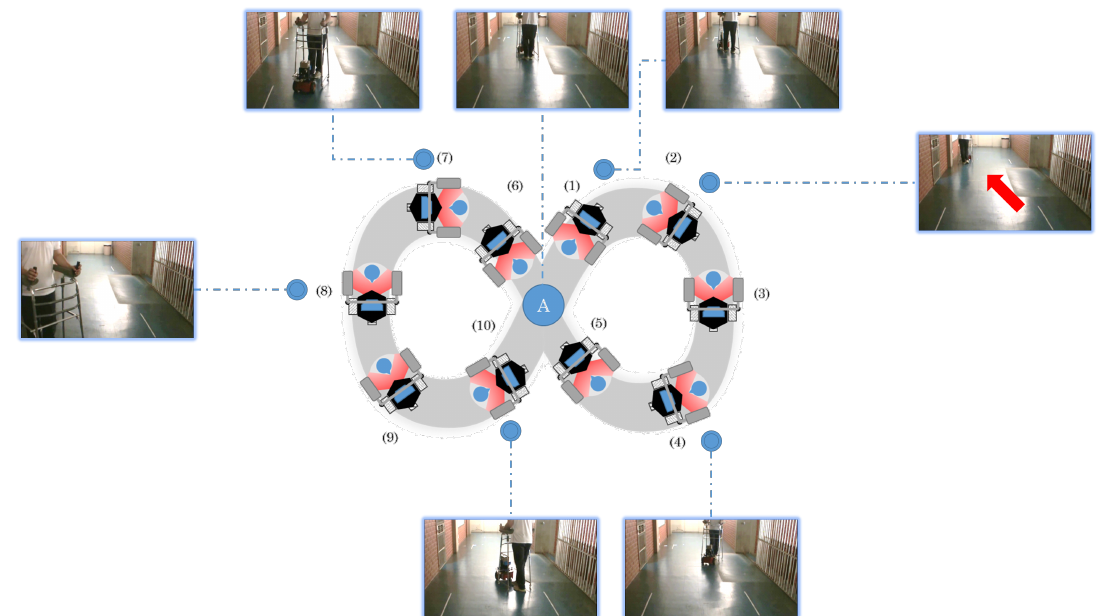
Figure 22. Lemniscate curve followed in the second set of experiments (with